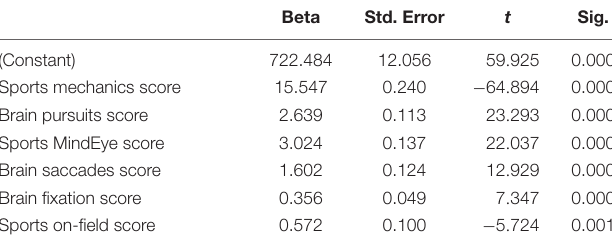
TABLE 6 | Model characteristics for SR.